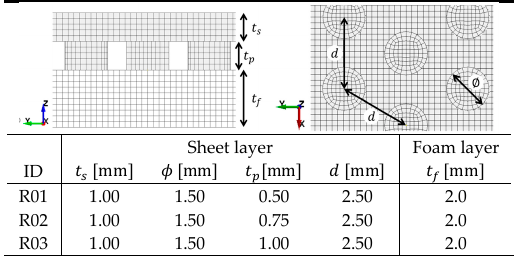
Table 4. This table shows the geometry and design parameters of pimples structure.